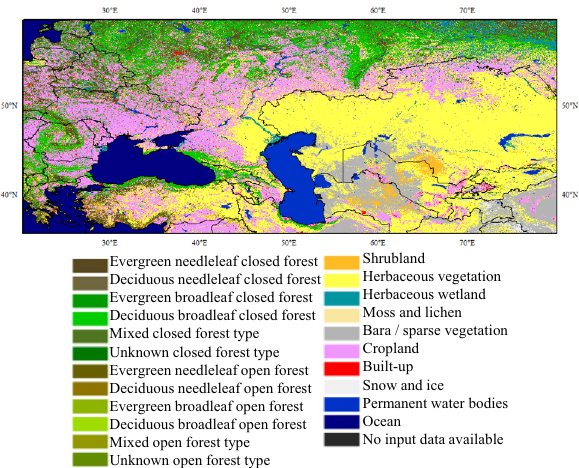
Figure 10. Land cover map of hotspot-1 (around Ukraine and Kazakhstan). This figure was generated using ArcGIS version 10.1 (https:// www. esri. com/ en- us/ home). Shape for countries of the world downloaded from Geografía, SIG y Cartografía Digital. (http:// tapiq uen- sig. jimdo free. com). The land cover data was from Buchhorn et al. 32 (https:// land. coper nicus. eu/ global/ produ cts/ lc).